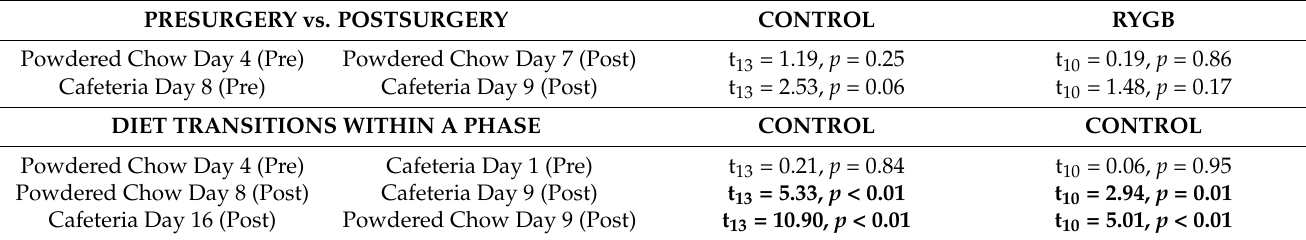
Figure 6. Meal Sizes across All 22-H Periods during Meal Pattern Monitoring. Mean (±SE) for CTL (combined SHAM and IRON groups, n = 14; orange circles) and RYGB ( n = 11; blue triangles) rats for powdered chow days (PC), acclimation days for each food (Acclim.; CF: chickpea flour; Y: yogurt; PB: peanut butter; SFW: sugar/fat whip), and cafeteria diet days. Dashed vertical lines indicate transitions between diet conditions (thin dashed) and between pre- and post-surgical phases (thick dashed). Statistically significant results from two-way mixed ANOVAs (Table 4) are indicated by horizontal lines: Gray solid (group), dark gray solid (day), or gray dashed (group × day interaction). *: Statistically significant result of a paired t -test (Table 5) for the group indicated by color, comparing the marked day to the previous day. Table 5. Paired t -tests Comparing 22-H Meal Sizes within Groups across Diets. PRESURGERY vs.